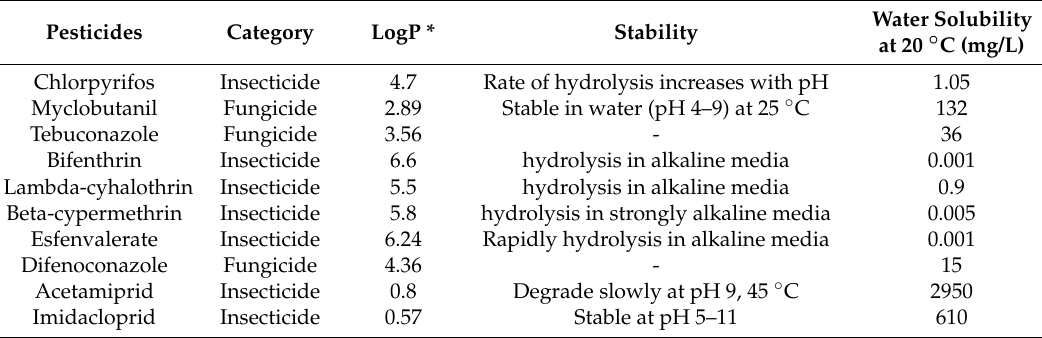
Table 1. The main properties of the studied